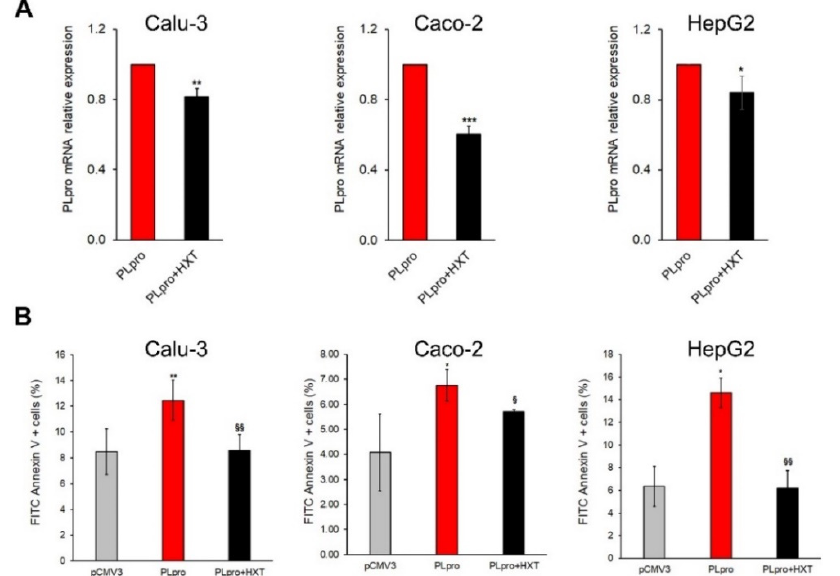
Figure 2. Treatment with HXT down-regulates PLpro mRNA expression and reduces apoptosis in epithelial cells. ( A ) PLpro mRNA expression in Calu-3, Caco-2 and HepG2 cells before and after treatment with 10 µ M HXT for 24 h. ( B ) Percentage of apoptosis measured by FITC Annexin V in pCMV3 Calu-3, Caco-2 and HepG2 cells, and in PLpro cells treated or not with 10 µ M HXT for 24 h. Values are plotted as mean ± SD of three independent experiments repeated at least in duplicate. Data were analyzed by 2-tailed t -tests, * p < 0.05, ** p < 0.01, ** p < 0.001 vs. pCMV3; § p < 0.05, §§ p < 0.01 vs. PLpro.